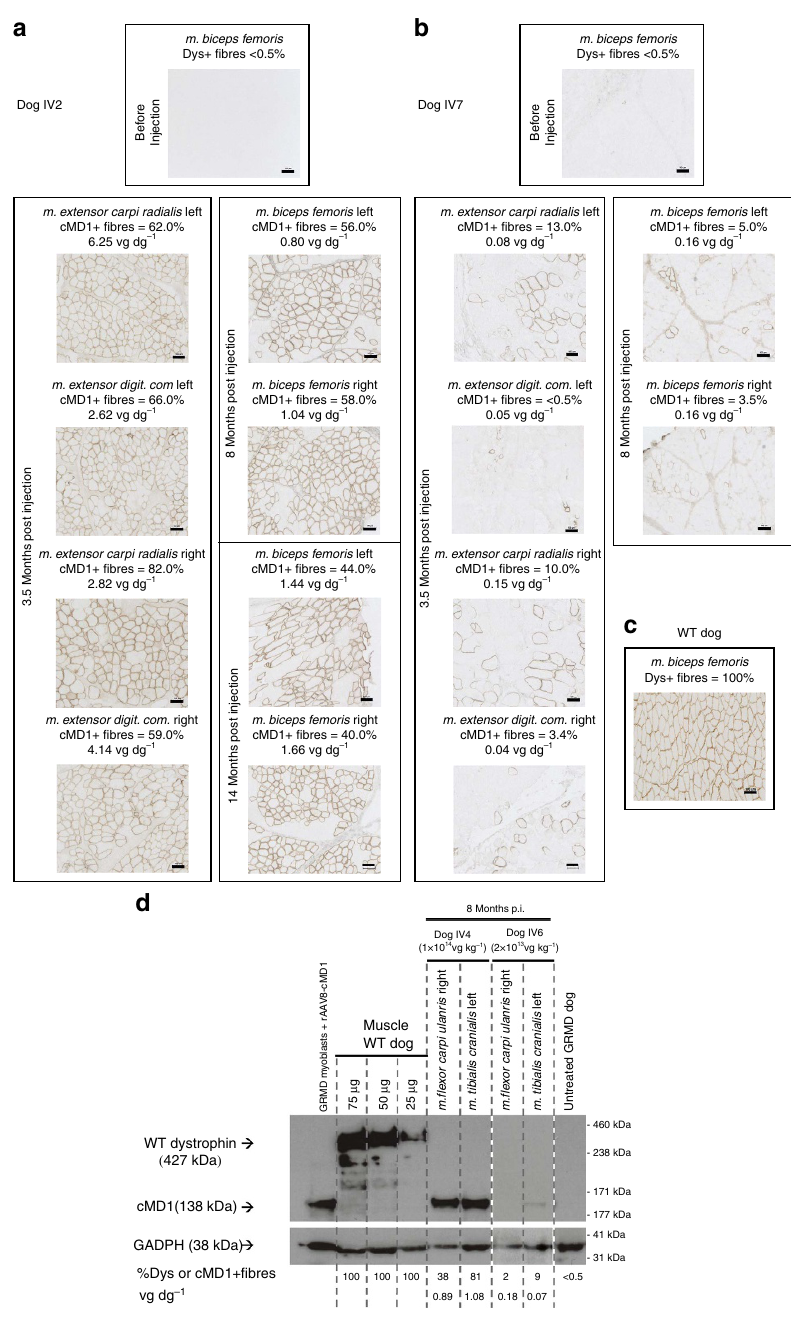
Figure 5 | Analysis of cMD1 expression by immunostaining and western-blot in muscular biopsies of GRMD dogs injected with rAAV2/8-Spc512- cMD1 by the IV route. ( a – c ) Dystrophin immunostaining (NCL-DYSB) on transverse sections of muscle samples. Representative results are presented for two treated GRMD dogs injected with different doses of the rAAV2/8-Spc5.12-cMD1 vector by the IVroute: dog IV2, injected with 1 (cid:2) 10 14 vgkg (cid:3) 1 ( a ) and dog IV7, injected with 2 (cid:2) 10 13 vgkg (cid:3) 1 ( b ). A healthy (WT) dog is also presented as control ( c ). For the treated dogs, different muscle samples were obtained after surgical biopsies performed before injection, at 3.5 months post injection, at 8 months post injection and at 14 months post injection (only for Dog IV2 for this latter time point). The level of cMD1-positive fibres is indicated above each panel, as well as the number of vector genomes per diploid genomes detected by qPCR in the same muscle sample. Scale bar, 100 m m. ( d ) Western blot analysis of total proteins (50 m g) extracted from muscles samples. Representative results are presented for two other treated GRMD dogs, injected with different doses of the rAAV2/8-Spc5.12-cMD1 vector by the IVroute: dog IV4, injected with 1 (cid:2) 10 14 vgkg (cid:3) 1 and dog IV6, injected with 2 (cid:2) 10 13 vgkg (cid:3) 1 . Then, 50 m g of total proteins extracted from GRMD myoblasts transduced with the rAAV2/8-Spc5.12-cMD1 vector were used as positive control, as well as 25 to 75 m g of total proteins extracted from a skeletal muscle of a WTdog. The blot was stained with MANEX-1011C to reveal the presence of the 427kDa dystrophin protein (WTdog) and the 138kDa cMD1 protein, with an anti-GAPDH antibody as a loading control. The level of cMD1-positive fibres detected by immunostaining as well as the number of vector genomes per diploid genomes detected by qPCR from the same muscle samples are indicated under each